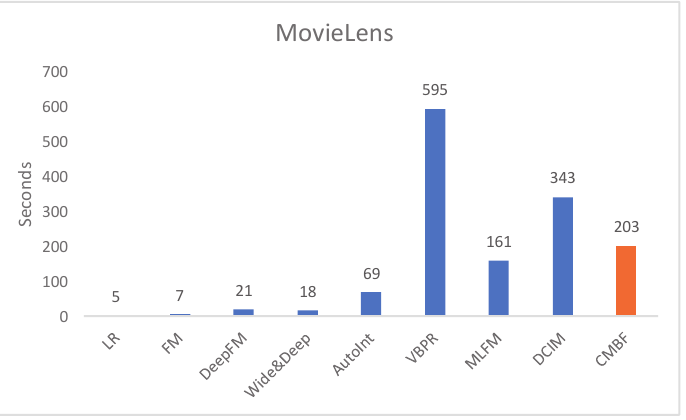
Figure 4. Run time per epoch of different algorithms on the MovieLens dataset.